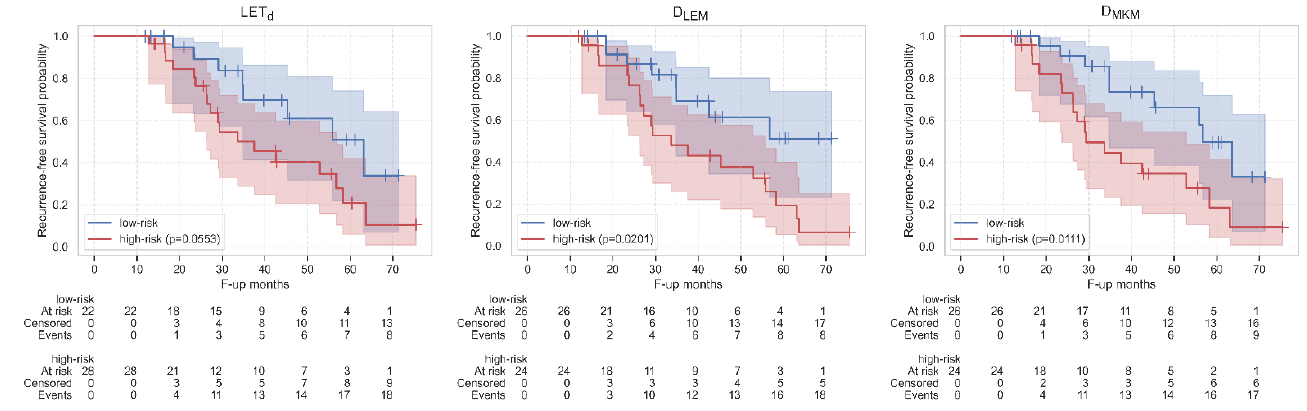
Figure 3. Kaplan–Meier survival curves for patients at high-(red) and low-risk (blue) of an LR as stratified by r-Cox using LET d ( left ) D LEM ( middle ), D MKM ( right ) features selected by LASSO. Shaded areas show curves confidence intervals and the p -values obtained from the comparison between high- and low- risk patients are reported in the legend. Censored events are highlighted with the symbol ‘+’. Below the plot, the number of patients belonging to each risk group at specific time points (months) is reported.